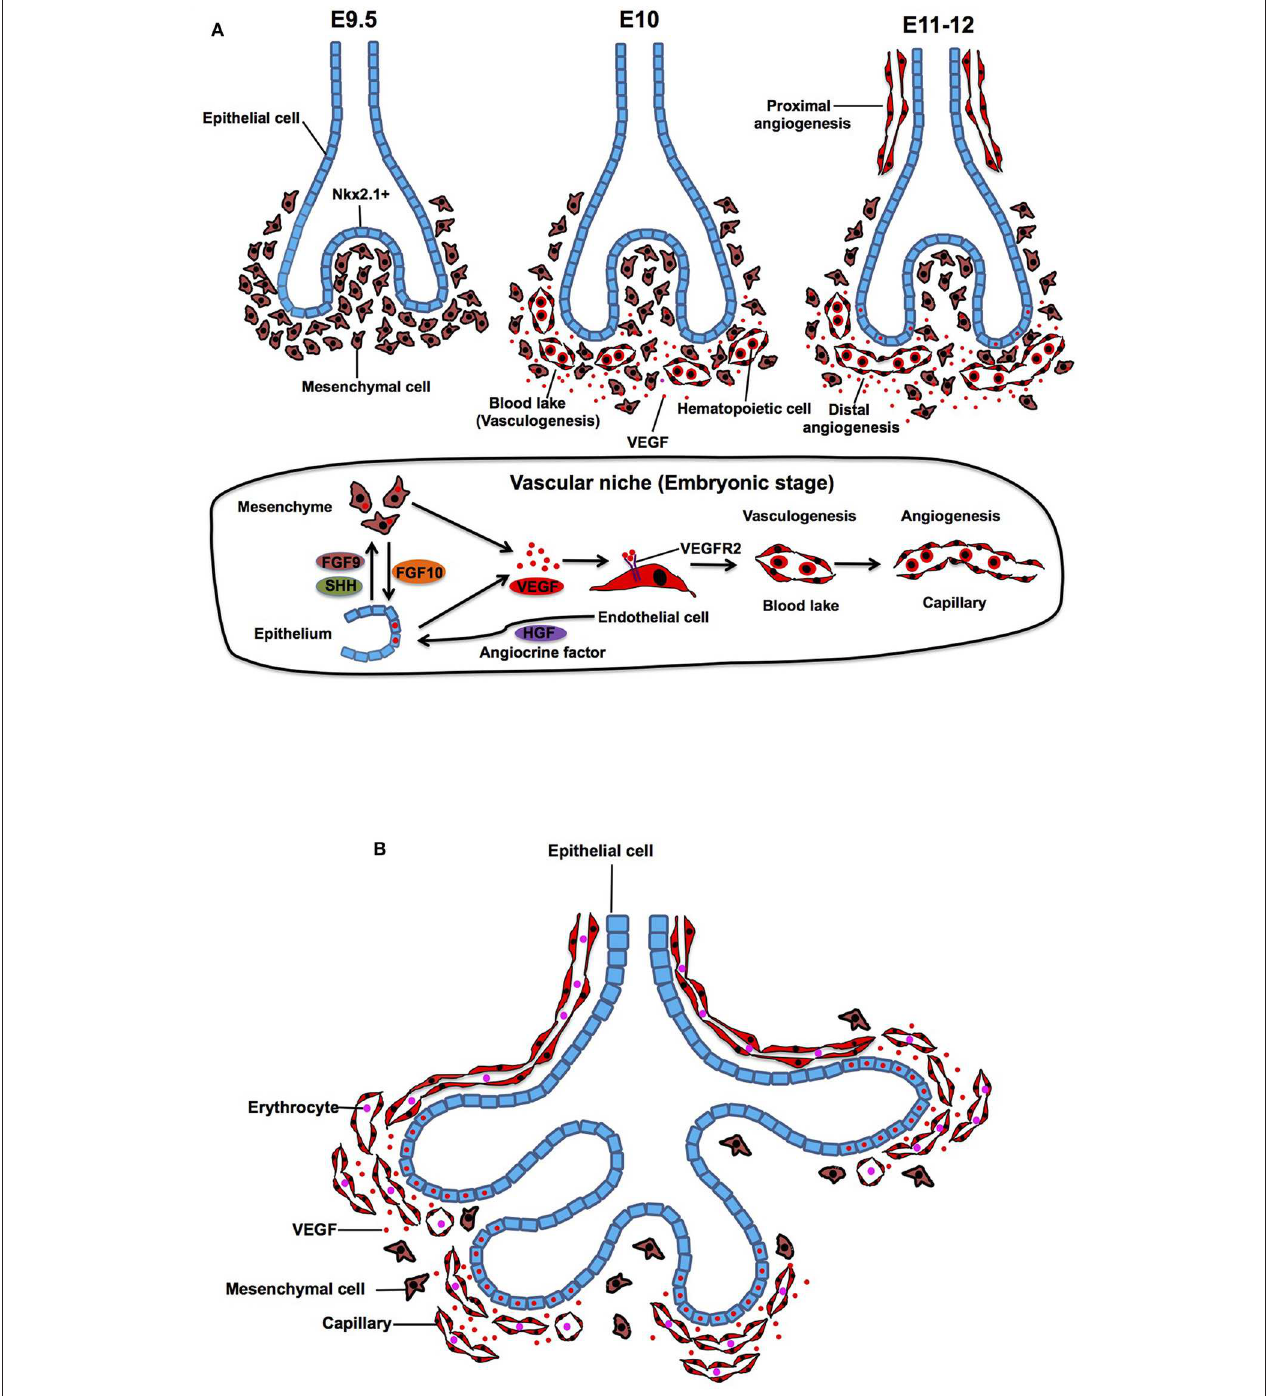
FIGURE 1 | Embryonic and pesudoglandular stage. (A) During the embryonic stage, NKX2.1 + epithelial buds grow and protrude into the mesenchyme (E9.5). Density of the mesenchyme becomes sparse and mesenchymal cells start expressing VEGF and stimulate formation of blood lake (vasculogenesis), which is consisted of outer thin endothelial cells (ECs) and inner hematopoietic cells (E10). Blood lakes proliferate, migrate and coalesce into a primitive capillary plexus around the buds (angiogenesis) (E11-12). In the vascular niche, expression of VEGF, which stimulates alveolar capillary network around the buds, is controlled by epithelium-derived morphogens such as FGF9 and SHH. Mesenchyme-derived FGF10 also triggers the production of VEGF in the epithelium. Capillary EC-derived HGF controls lineage commitment in the airway epithelium. (B) During the pesudoglandular stage, repeated epithelial branching starts and proximal artery and vein start communicating with the capillaries around the buds. Mesenchyme becomes sparse and the main source of VEGF shifts from mesenchyme to the epithelium, which results in attraction of capillary ECs toward the epithelium.